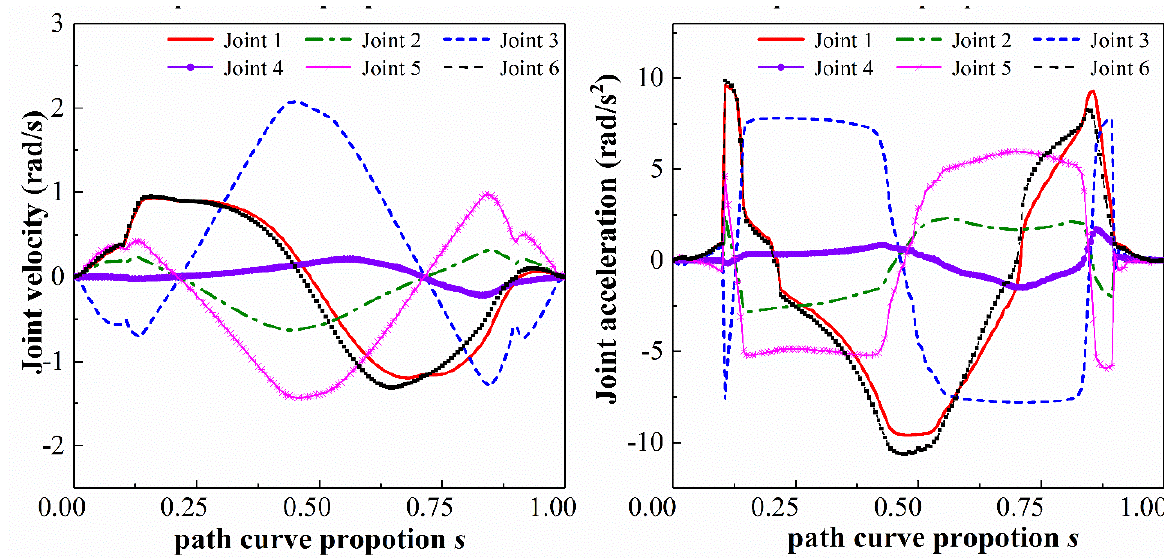
Figure 7. Optimized trajectories for robot joint with the proposed method when α = 0.1.